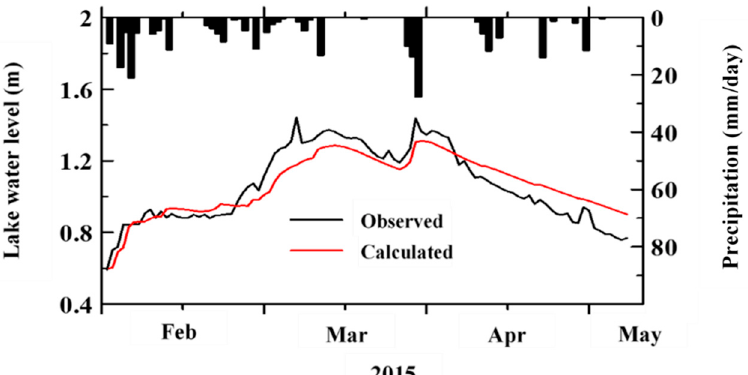
Figure 13. The simulated lake water level: the SWAT parameters calibrated with Masri reservoir catchment (Hilly and Calcisol soil) were applied to the lower catchment. The parameters used for the mountainous catchment were calibrated with Joumine reservoir catchment.